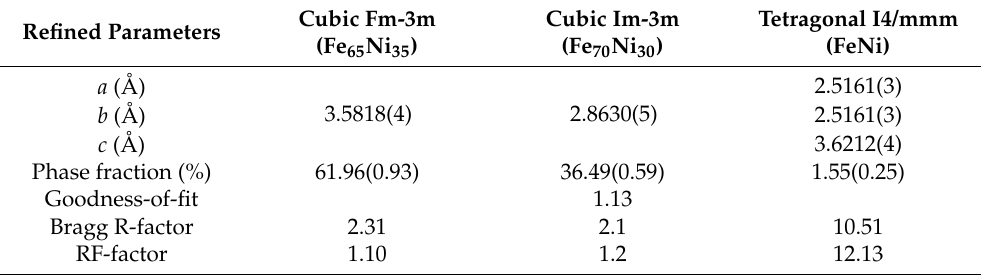
Table 1. Structural and fitting parameters obtained from a Rietveld refinement.